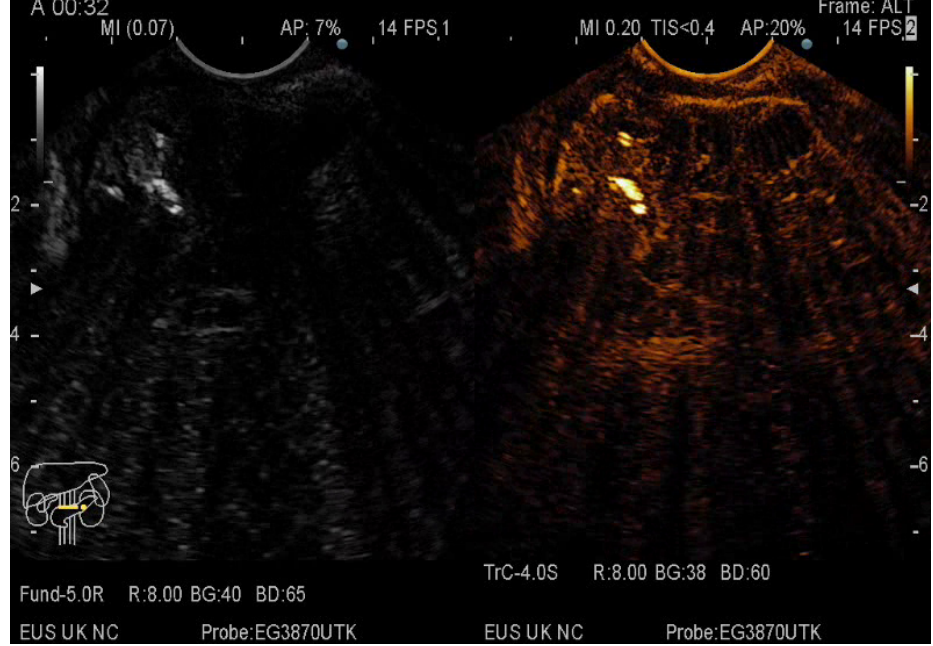
Figure 4. CE-EUS image of a MFP revealing a solid mass with hyperenhancement in the arterial phase and no wash-out in the venous phase.